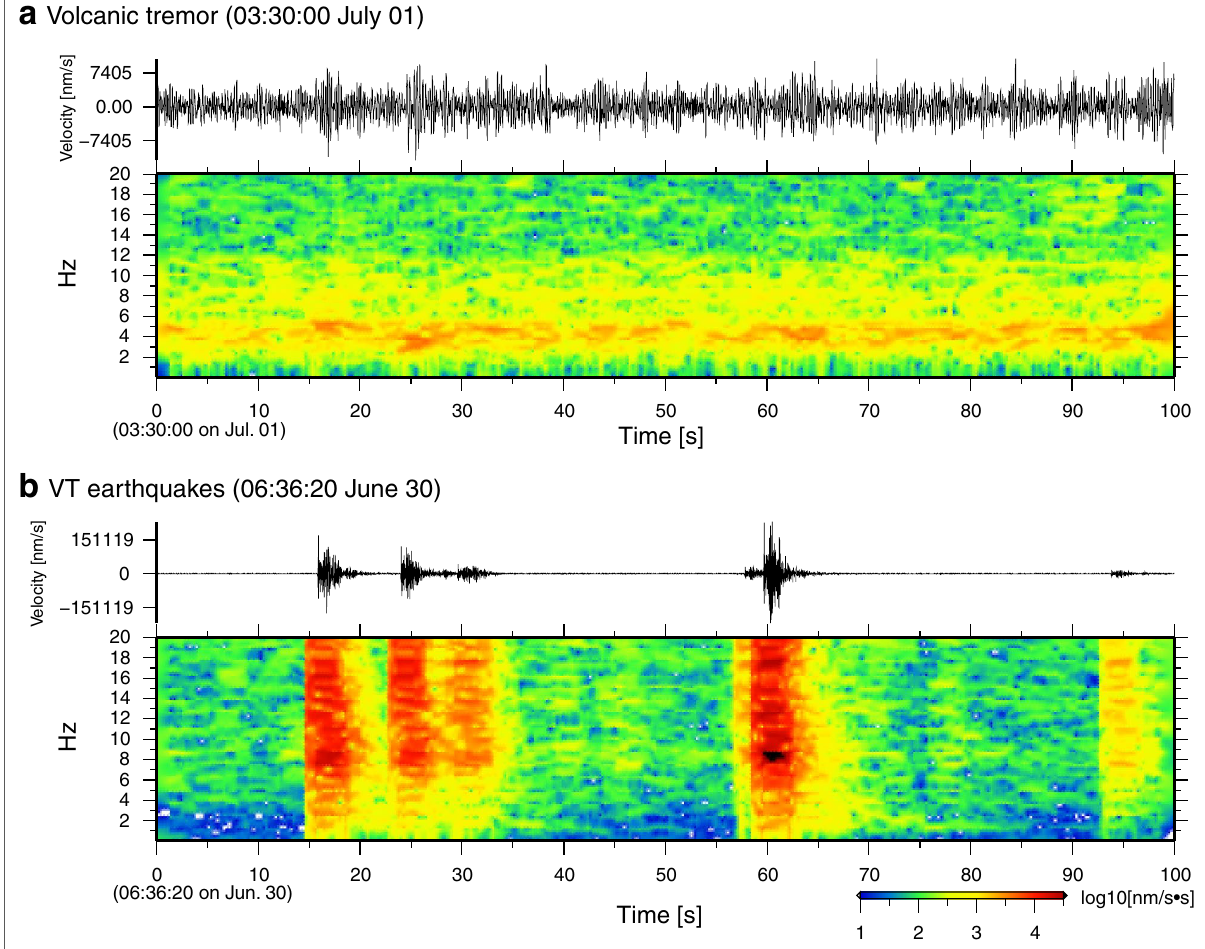
Fig. 4 Examples of the velocity waveforms (vertical component) and spectrograms at OWD station. a Volcanic tremor at 03:30:00 on July 1 and b VT earthquakes at 06:36:20 on June 30. Each spectrogram was calculated by using a 2.56 s time window with 0.2 s